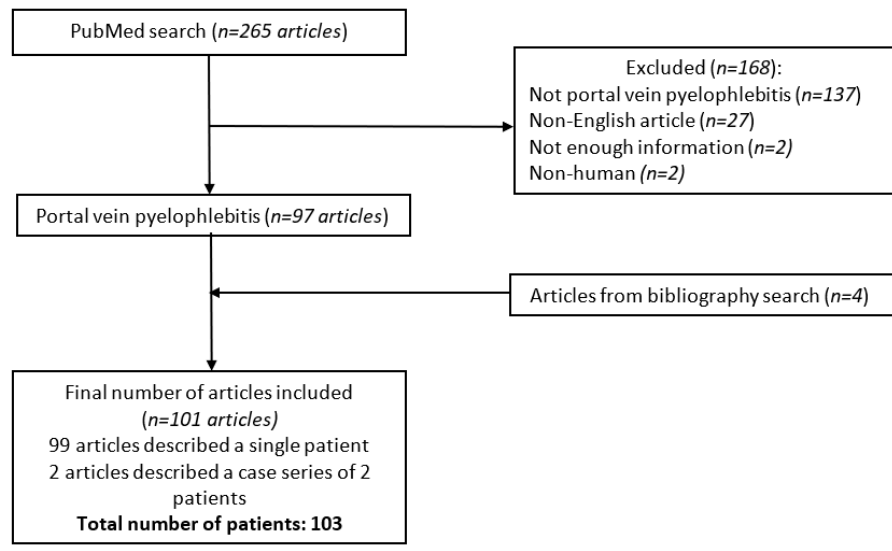
Figure 1. Detailed flowchart of the literature search and article inclusion according to PRISMA guidelines.